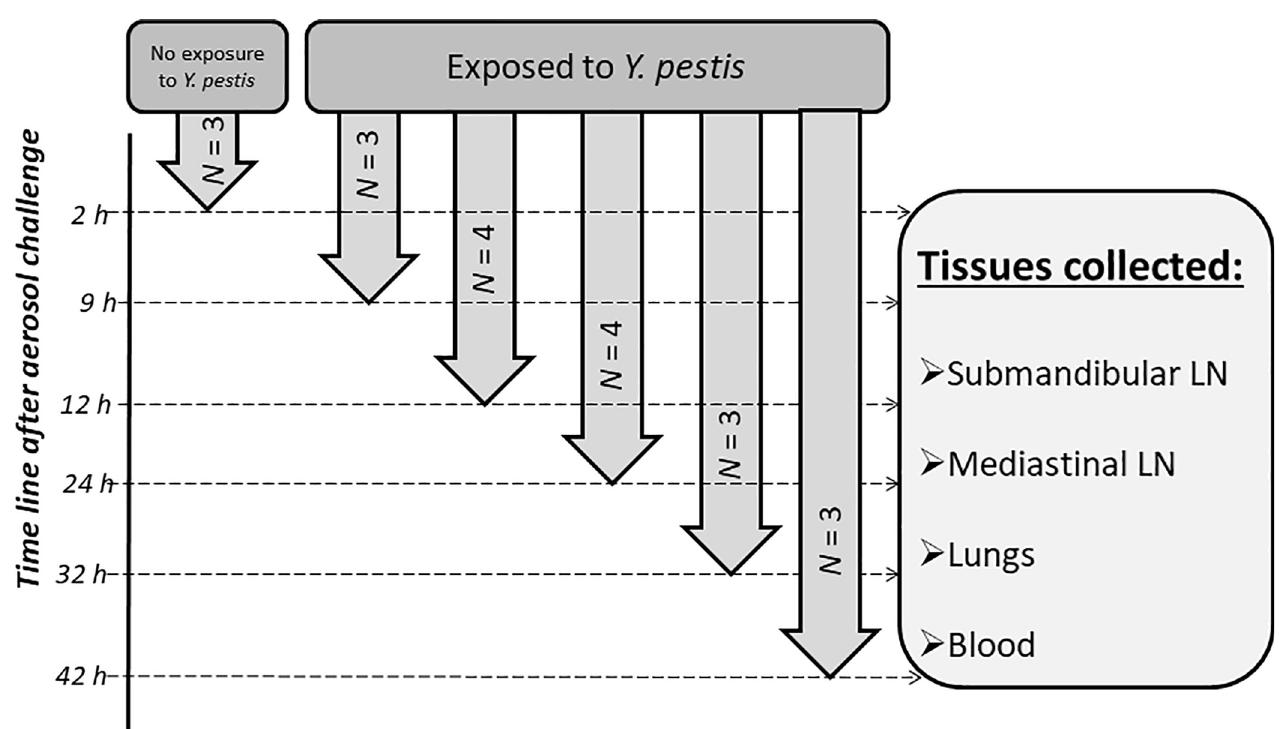
Fig 1. Schematic of experimental design and corresponding organ collection sequence. The timeline is not in scale. N : sample size; LN: Lymph node.